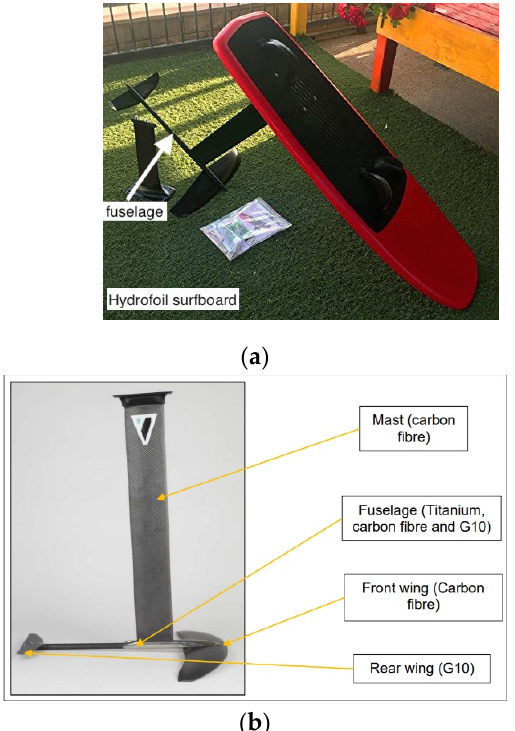
Figure 1. ( a ) Image shows a short hydro foil surfboard, ( b ) Illustration of component in hydro foil